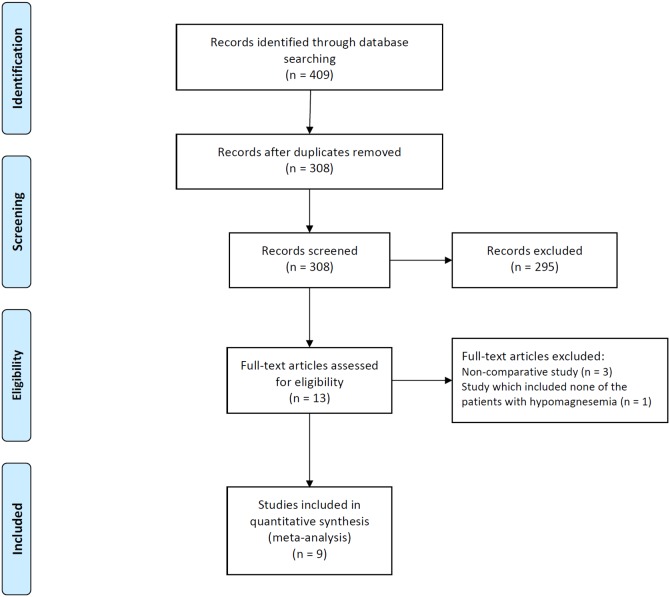
Flow diagram of studies included in the meta-analysis.PPI, proton pump inhibitor.